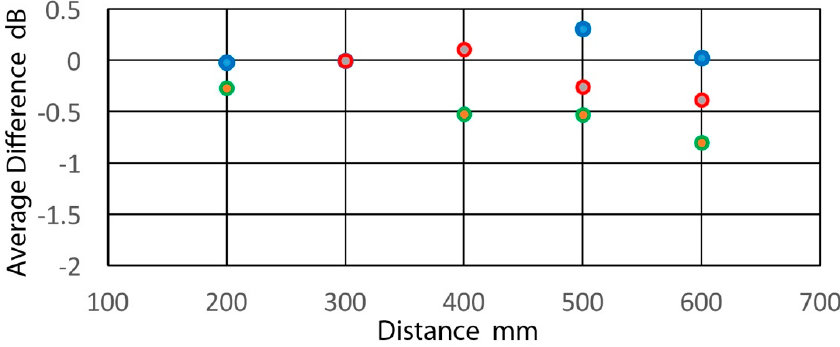
Figure 9. Effects of changes in L on the integrated signal intensity with two KRN sensors (#12053 and #12060). Red points: frequency range up to 0.5 MHz, Blue points: to 1 MHz, Green points: to 2 MHz.